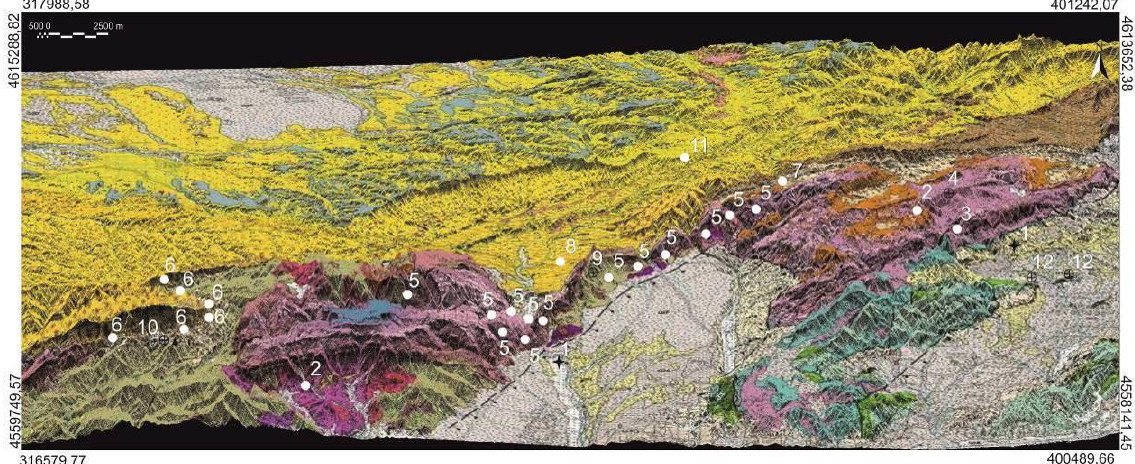
Figure 2. 3D Geological Map with the location of chert outcrops (www.icc.cat). Chert in primary